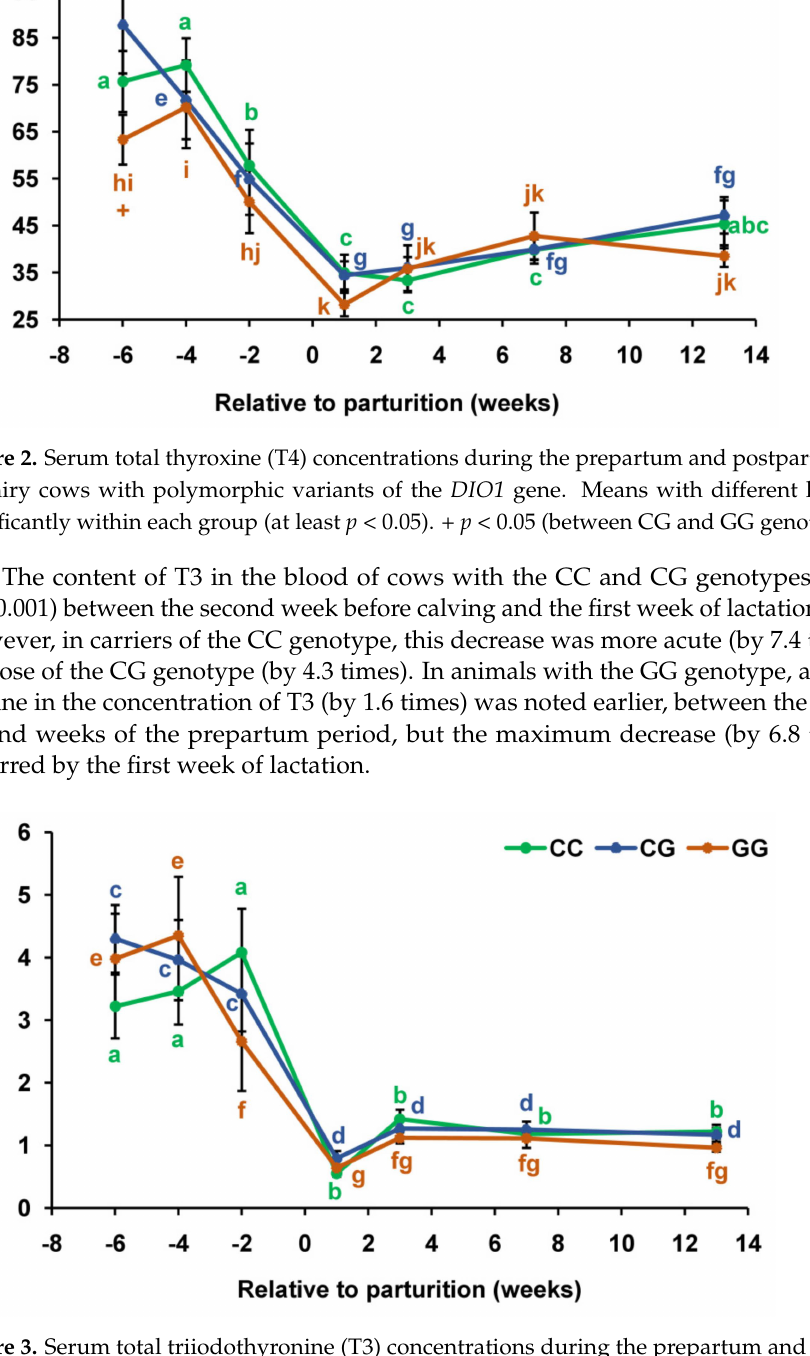
Figure 3. Serum total triiodothyronine (T3) concentrations during the prepartum and postpartum periods in dairy cows with polymorphic variants of the DIO1 gene. Means with different letters differ significantly within each group (at least p <